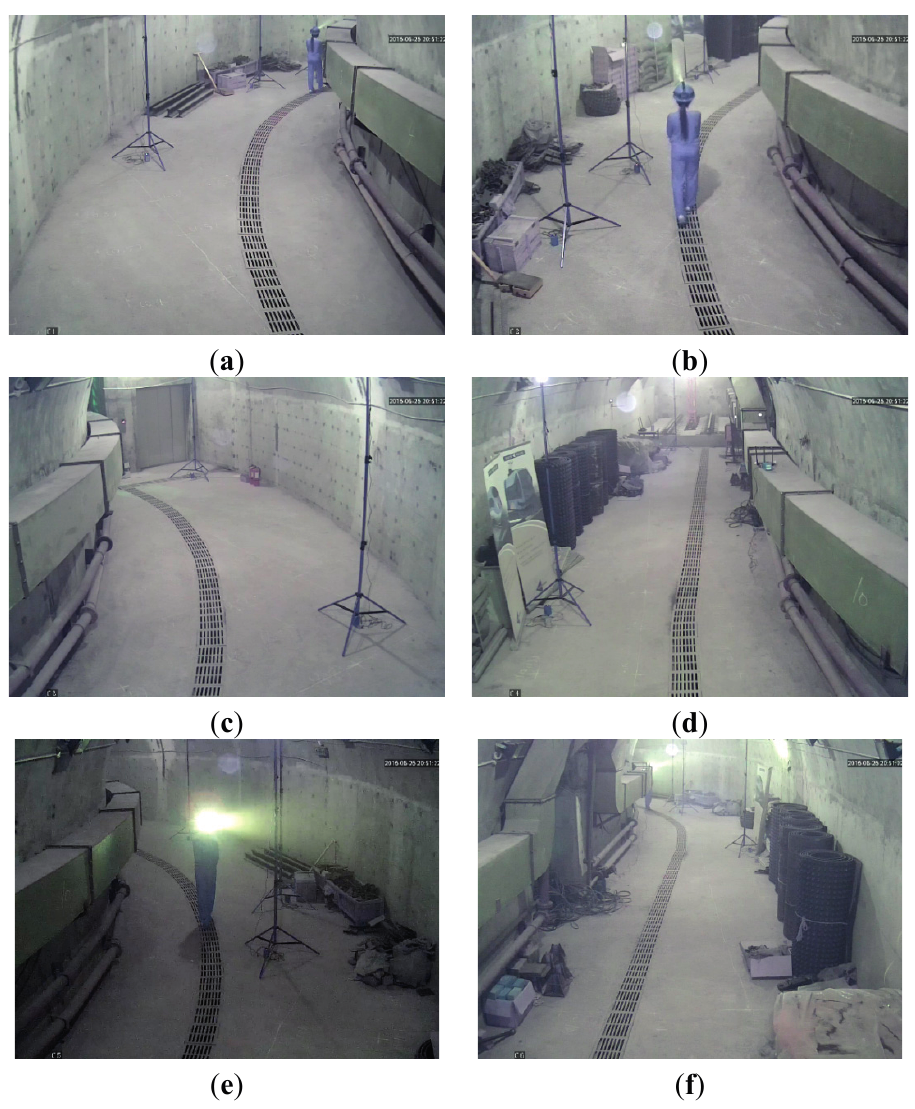
Figure 12. ( a ) The image of the tunnel taken by camera C 1 ; ( b ) The image of the tunnel taken by camera C 2 ; ( c ) The image of the tunnel taken by camera C 3 ; ( d ) The image of the tunnel taken by camera C 4 ; ( e ) The image of the tunnel taken by camera C 5 ; ( f ) The image of the tunnel taken by camera C 6